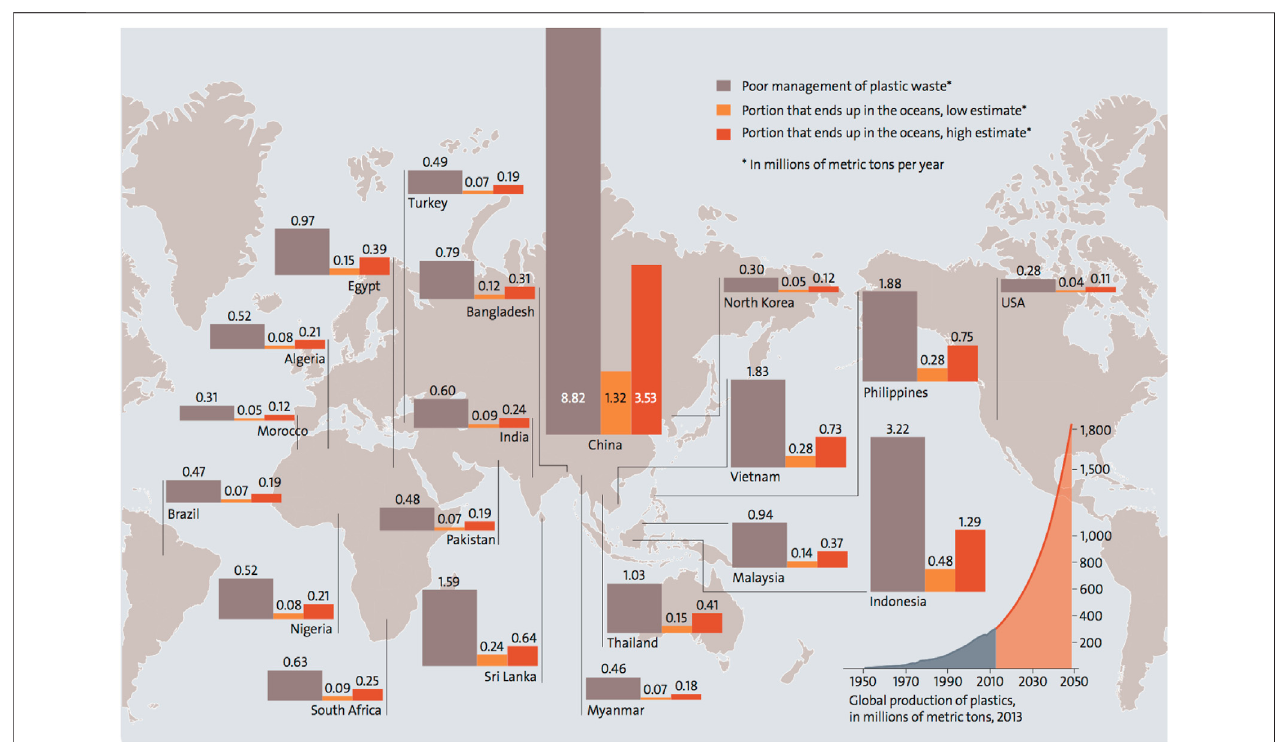
FIGURE 2 | Attribution of plastic waste pollution (in millions of metric tons per year) across the global (d ’ Ambrières, 2019).